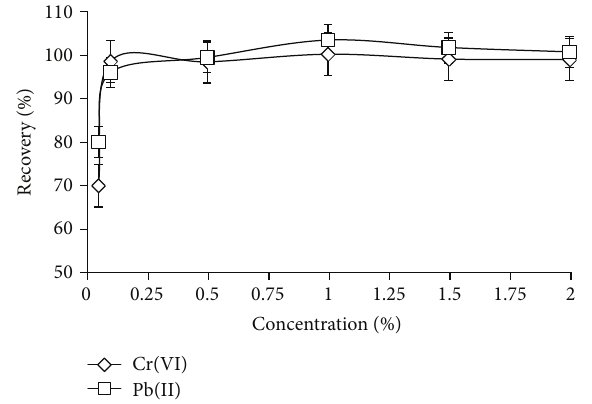
Figure 3: Influence of APDC concentration on DLLME for Cr(VI) and Pb(II) at 40mL initial volume of water samples pH 2.0 and 0.10mg/L Cr(VI)/Pb(II).